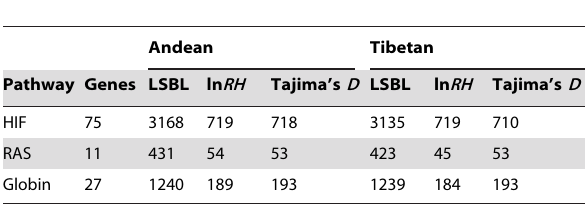
Table 2. Total LSBL SNPs, ln RH windows, or the standardized difference of D windows analyzed for the HIF pathway, RAS, and globin family.